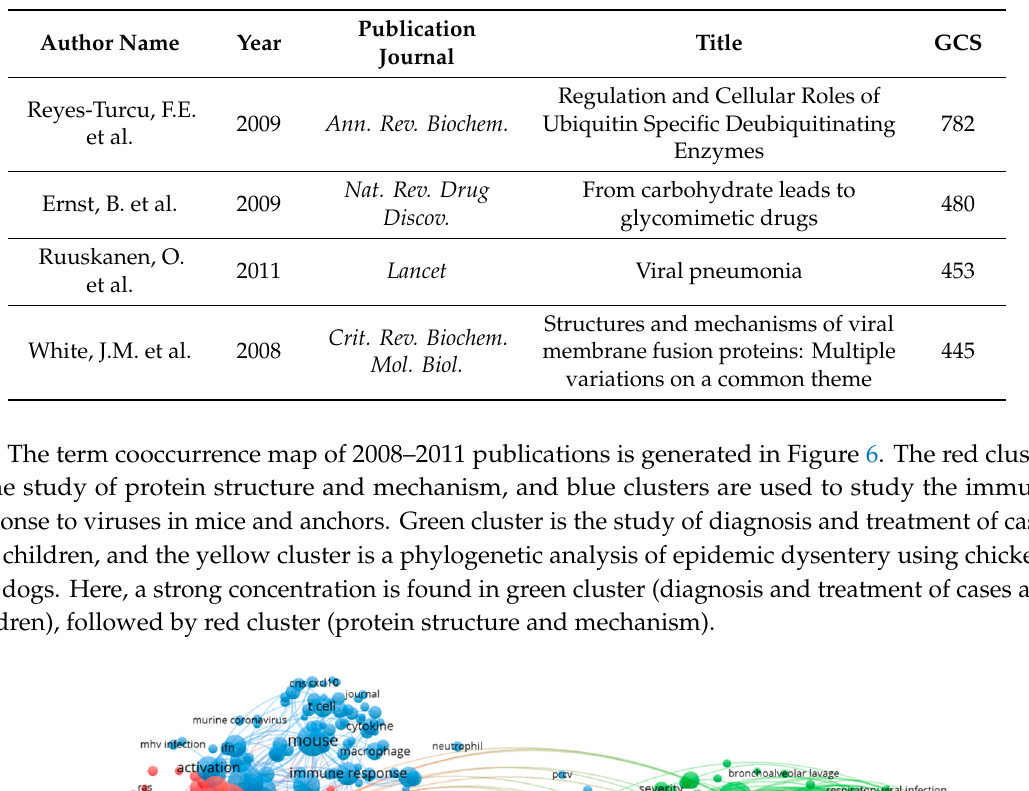
Table 6. Top cited papers with over 400 citations during 2008–2011.